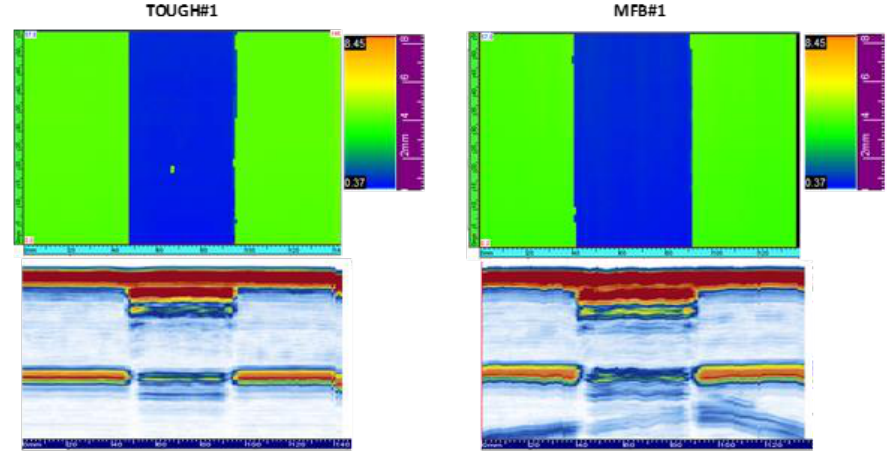
Figure 6. Ultrasonic inspection.